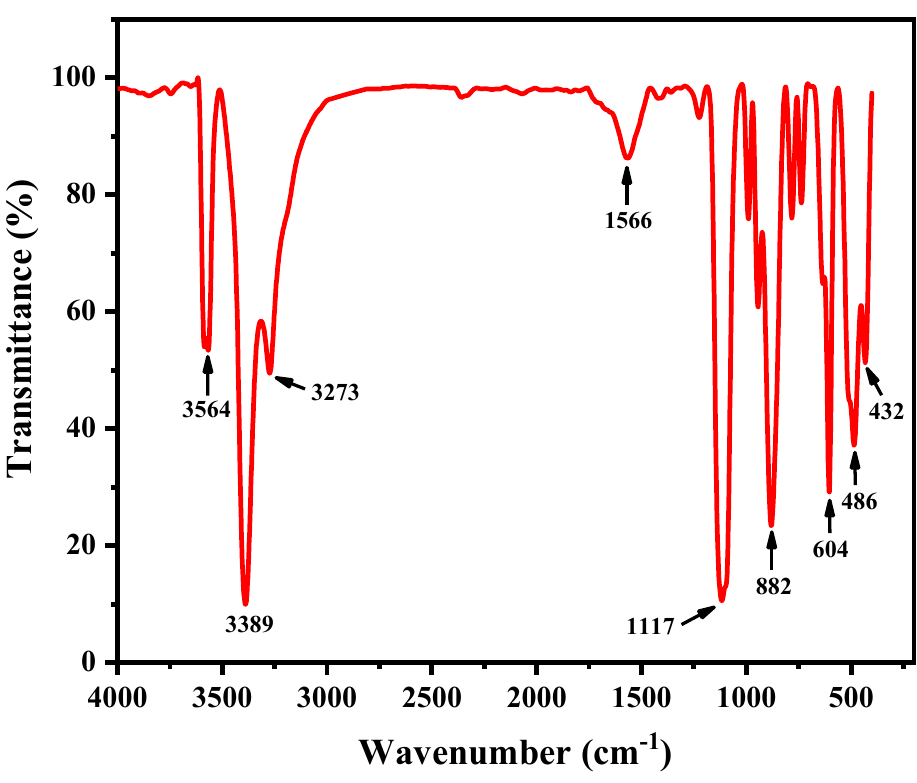
Figure 4. FTIR spectrum of the synthesized rGO-CuO nanocomposites.